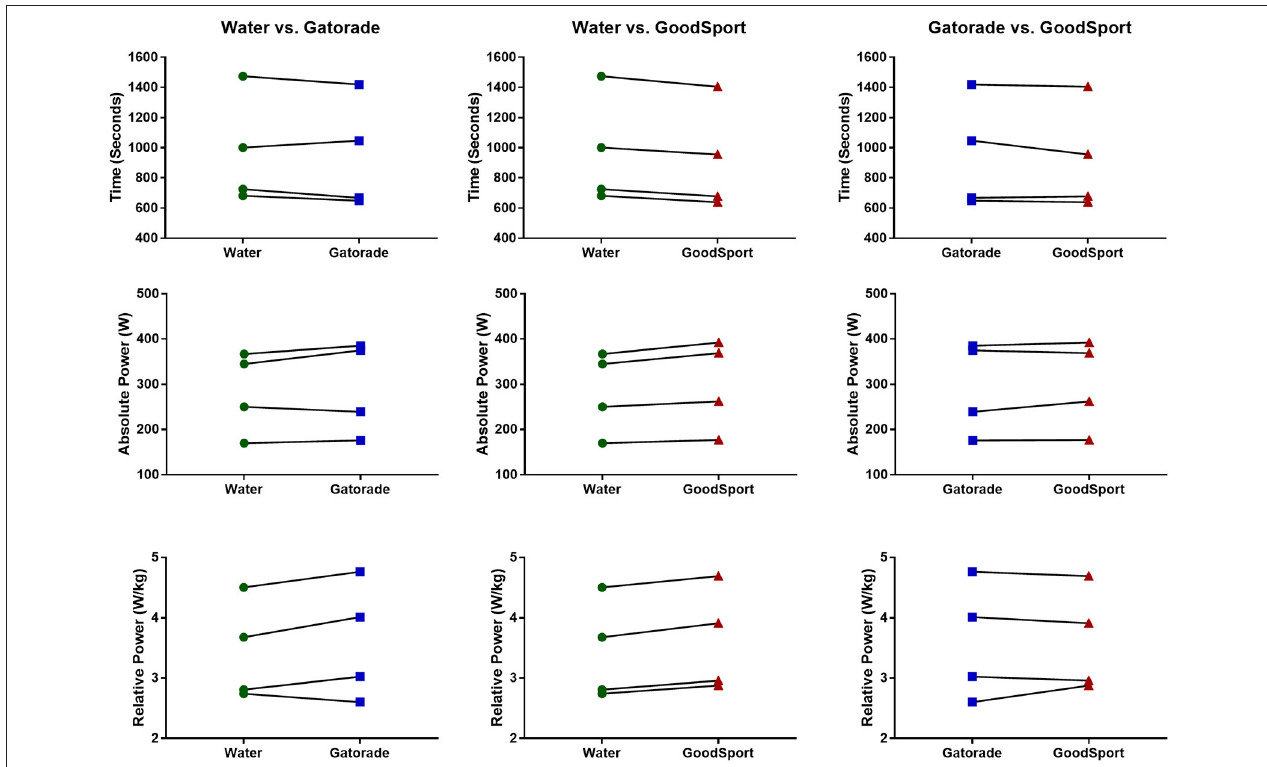
FIGURE 5 | Between-beverage comparisons of 250 kJ time-trial performance in thermoneutral conditions, measured as time (s), absolute power (W), and relative power (W/kg). All three measures of time-trial performance were improved on average in both Gatorade (GAT) and GoodSport (GS) compared to water (WAT). All four subjects improved in all measures of time-trial performance in GS compared to WAT, and three of four subjects improved in GAT compared to WAT. Symbols represent data points for each subject, and lines indicate changes in performance between trials for each